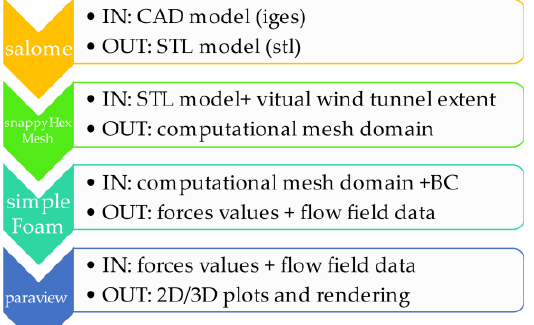
Figure 21. Schematic chart of the Open-Source based CFD analysis workflow.